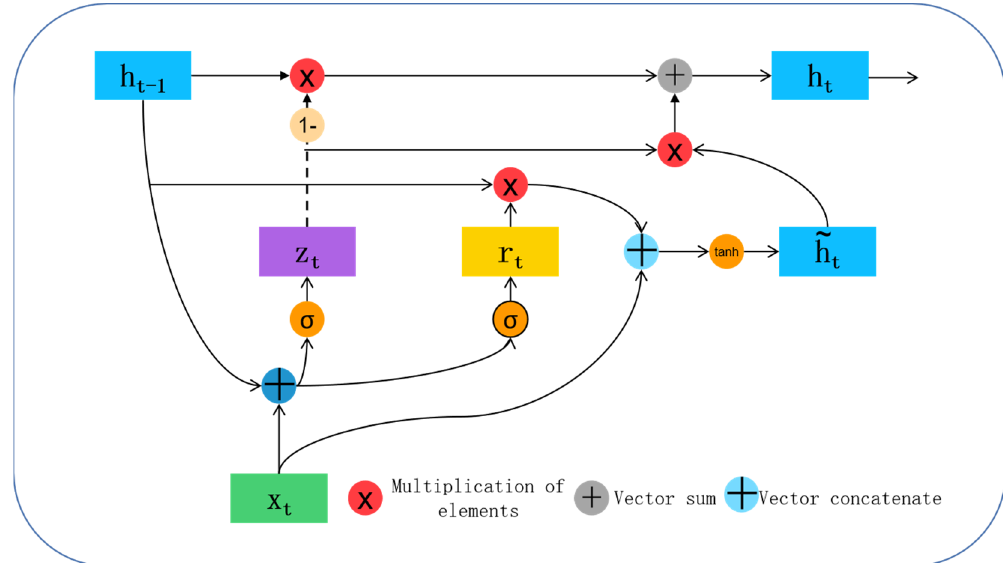
Figure 1. The structure of GRU unit.